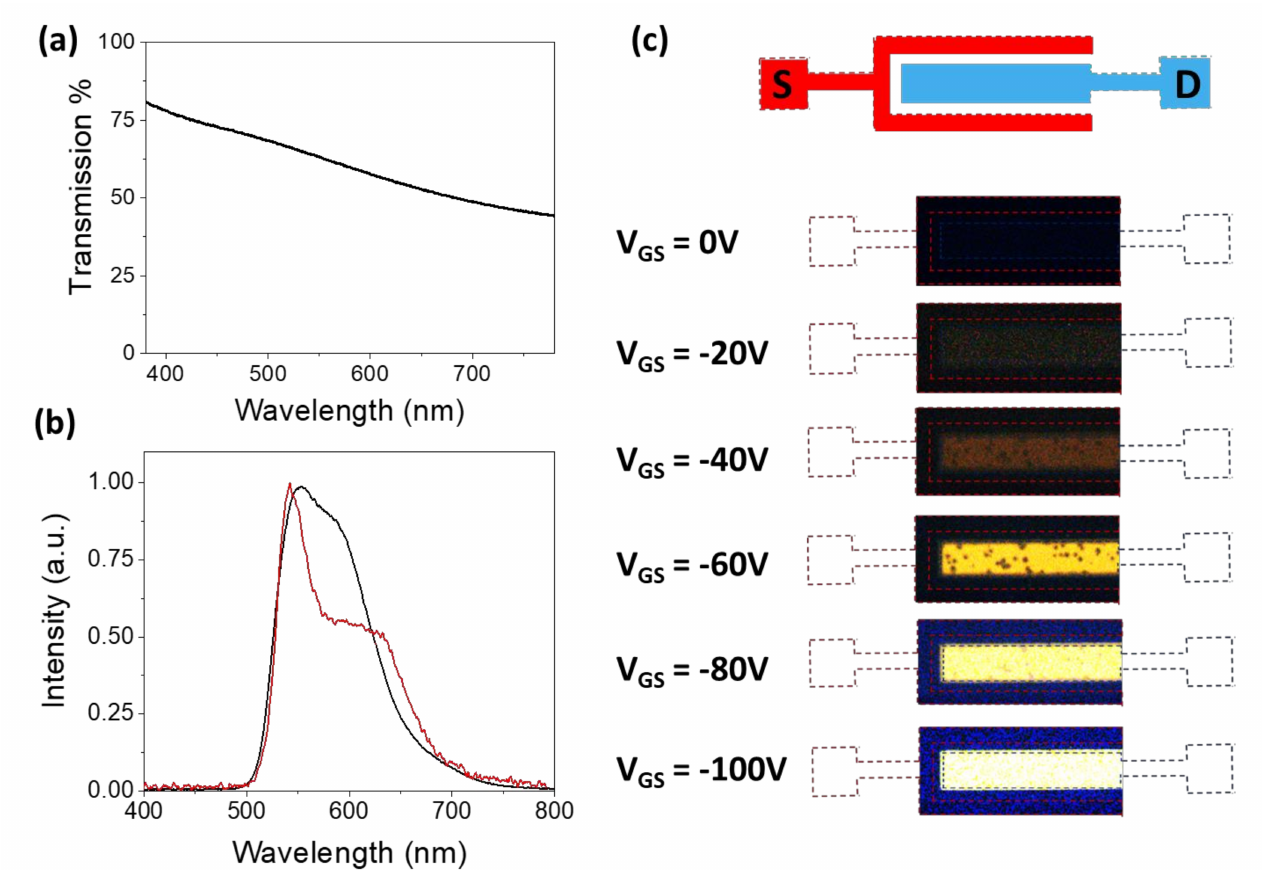
Figure 4. ( a ) Transmission of the electron-injecting electrode (Cs 2 CO 3 /Ag). ( b ) Electroluminescence (red) and photolumines- cence (black) spectra of emitted light in LEFET. ( c ) Micrograph of light emission from the drain electrode (0.4 mm × 1 mm) at gate voltages ranging from 0 V to 100